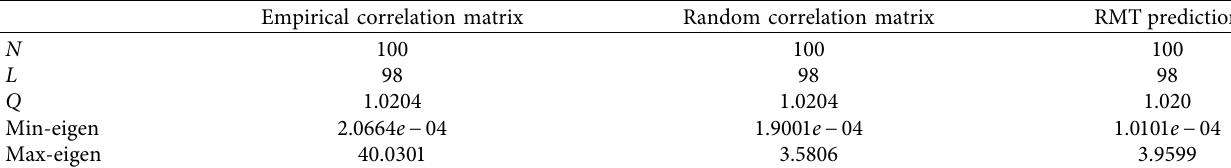
Table 2: Comparison of the eigenvalues of the empirical correlation matrix, random correlation matrix, and prediction. Empirical correlation